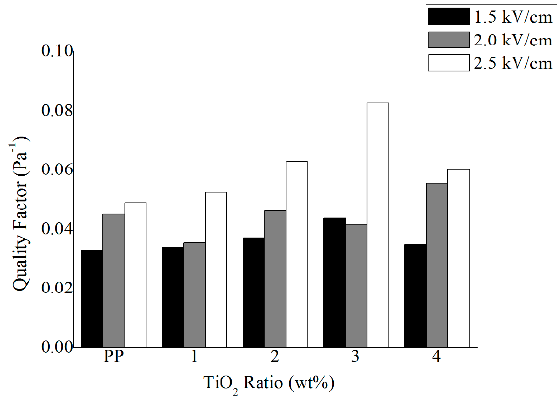
Figure 8. Quality factor of electret melt-blown fabrics as related to the ratio of TiO 2 (1, 2, 3, and 4 wt%) and electric field intensities of (a) 1.5, (b) 2.0, and (c) 2.5 kV/cm. The quality factor of non-electret pure PP melt-blown fabrics is 0.032.